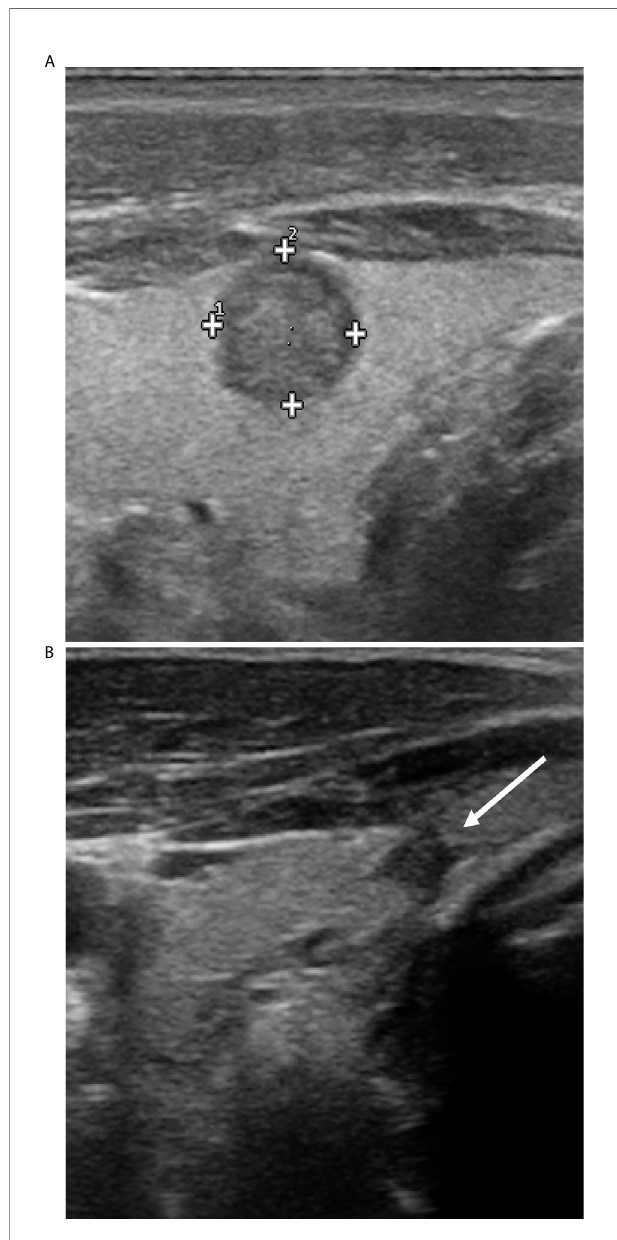
FIGURE 2 | Ultrasound features of the nodule before and after RFA. Before RFA (A) , the nodulation has a solid, irregular, hypoechoic structure, with slightly spiculated margins and microcalci fi cations. At control 12 months after RFA only a small nodular, hypoechoic and homogeneous area is appreciable (B) ; it is in contact with the thyroid capsule that appears slightly retracted but with no signs of extra-thyroidal